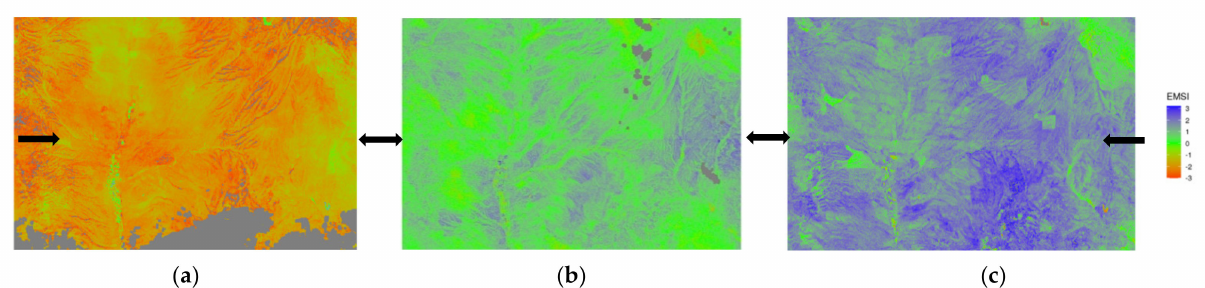
Figure 8. Select years for the August Landsat time series EMSI along the US-Mexico border (black arrows) ( a ) during drought-like highly stressed conditions in 1994, note the stable irrigated areas in the south western side in Mexico, ( b ) above normal and robust conditions in 2001 on both sides of the border, and ( c ) an exceptional year in 2016 with several cattle pastures under increased grazing pressure having reduced but still robust values, these are apparent on both sides of the border; fallowed fields in Mexico appear as stressed and disturbed. Note the international border fence runs through the center of all three scenes. Pixels with no data due to masking are